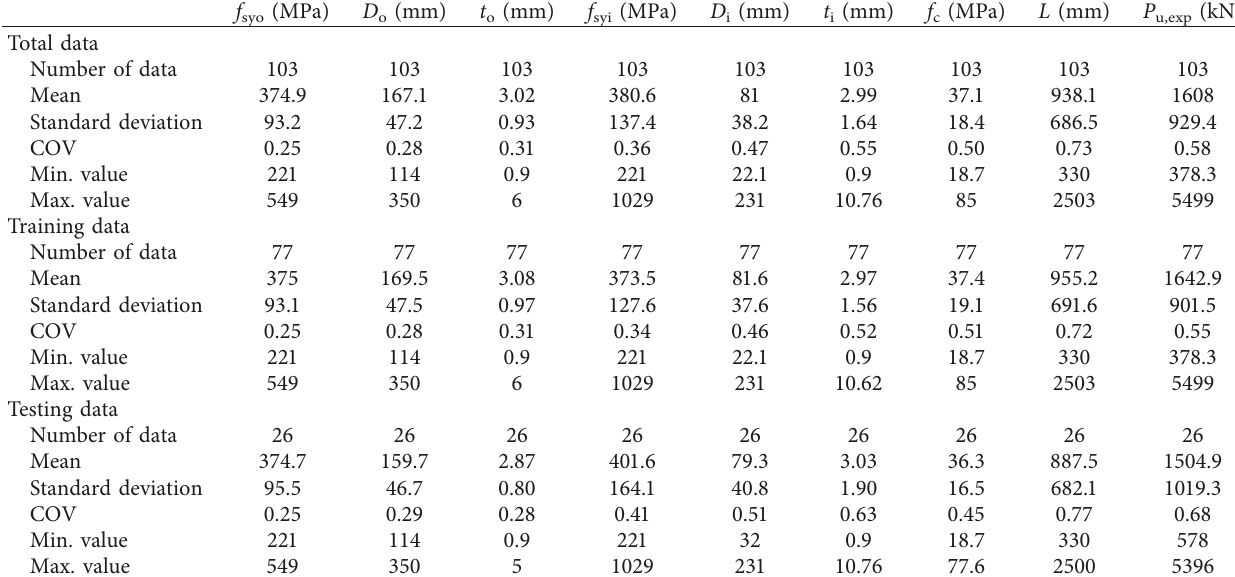
Table 2: Statistics of the experimental data used in the model derivation.